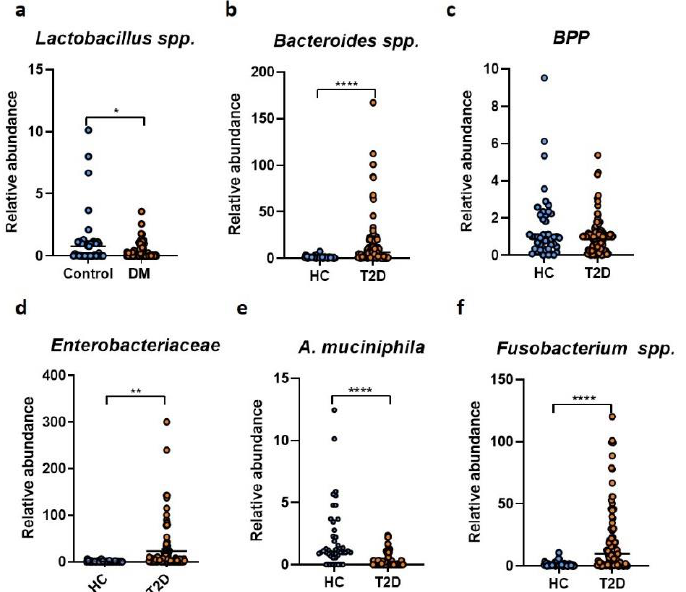
Figure 2. Microbiota analysis in T2D patients ( n = 105) versus healthy controls ( n = 45). The relative abundance of the Lactobacillus spp . ( a ), Bacteroides spp . ( b ), Bacteroides–Porphyromonas–Prevotella ( c ), Enterobacteriaceae ( d ), A. muciniphila ( e ) and Fusobacterium spp . ( f ) in fecal samples harvested from healthy individuals and T2D patients. *, p < 0.05, **, p < 0.01, **** p < 0.0001. Akkermansia muciniphila , a gut microbe constantly associated with metabolic health [24], was significantly diminished in the T2D cohort compared to the HC group (Figure 2e). In addition, T2D patients were characterized by a significant increase in Fusobacterium species (Figure